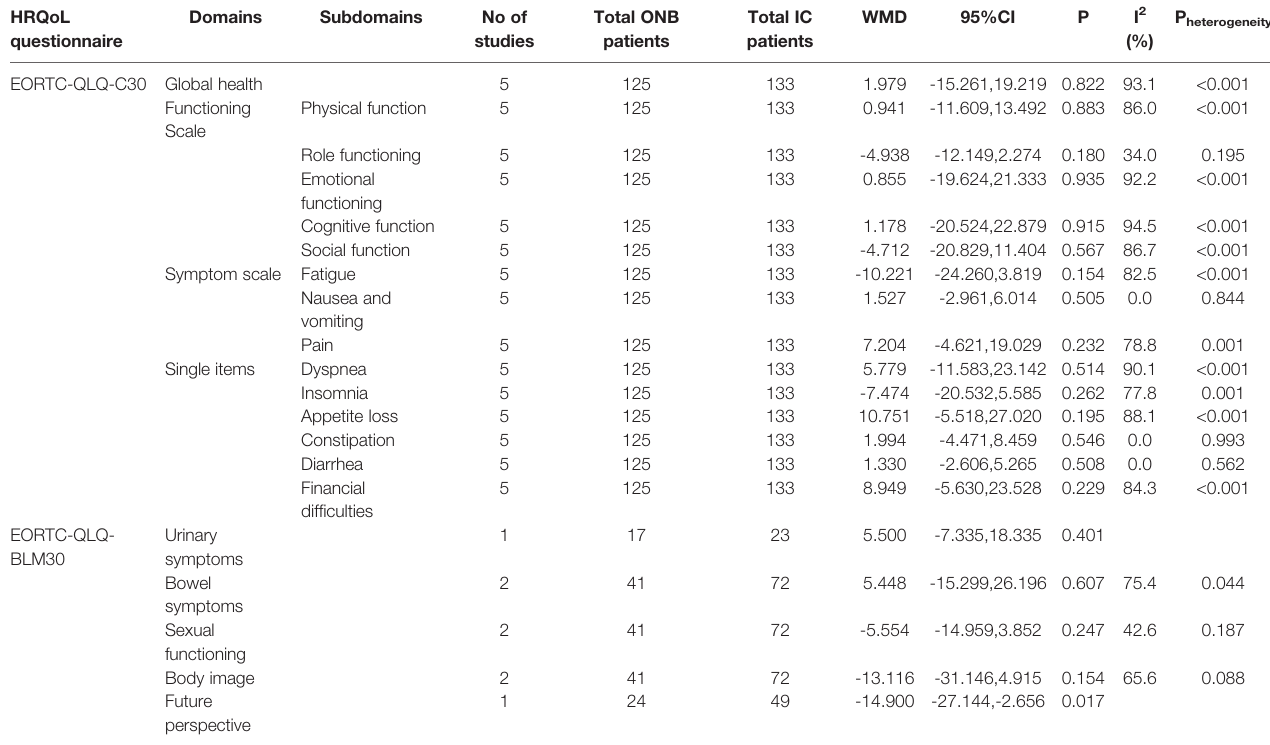
TABLE 2 | Summarized results of the meta-analysis by effects of orthotopic neobladder (ONB) versus ileal conduit diversion (ICD) on the HRQoL. HRQoL questionnaire